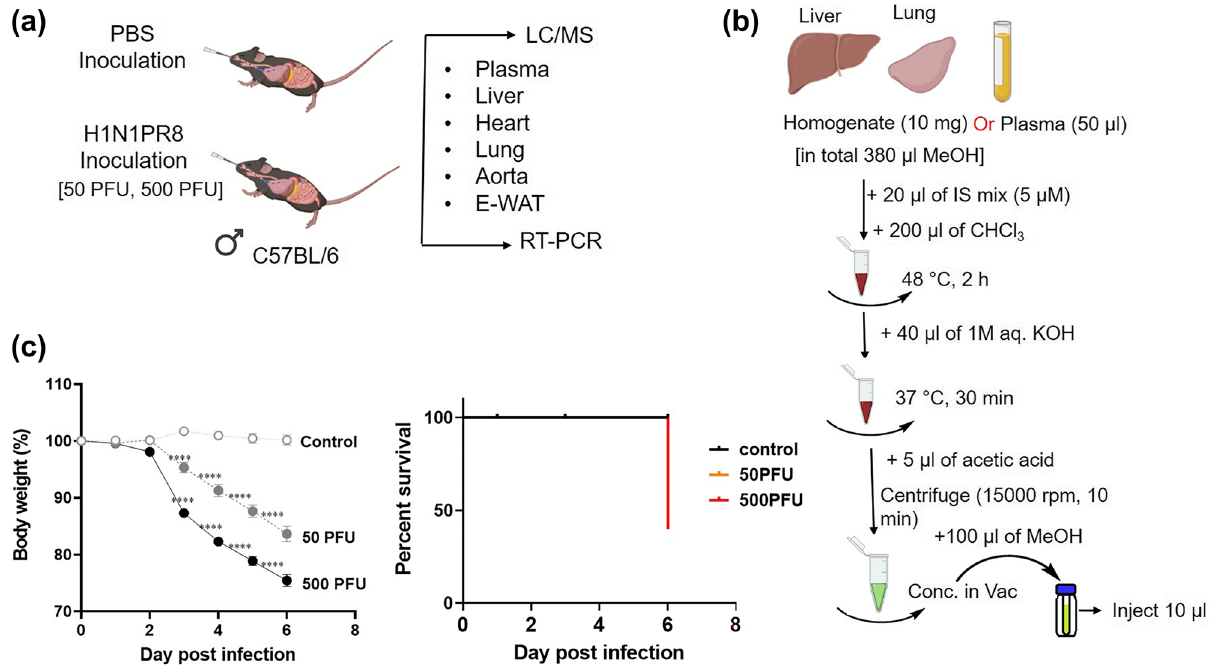
Figure 1. Experimental design ( a ), sphingolipid extraction workflow ( b ), and changes in body weight and survival rate ( c ), after virus inoculation. Mice were intranasally inoculated with PBS control or PBS comprising PR8 virus (50 or 500 PFU), and body weight was daily monitored until 6 dpi. A total of 15 mice/group were used for the experiment and 5 mice each were euthanized for sample collection on 1, 3, and 6 dpi. The mean body weight of mice is represented as a percentage of the original weight ( c ). White, gray, and black symbols indicate PBS control, 50 PFU, and 500 PFU PR8 virus infected mice, respectively; **** p < 0.0001, Mixed-effects analysis with Tukey’s multiple comparison test. ( c ) Percent survival of each group is shown. Black, orange, and red bars indicate PBS control, 50 PFU, and 500 PFU PR8 virus infected mice, respectively. Survival curves are compared using the log-rank (Mantel–Cox) analysis; * p < 0.05. Images are adopted from licensed